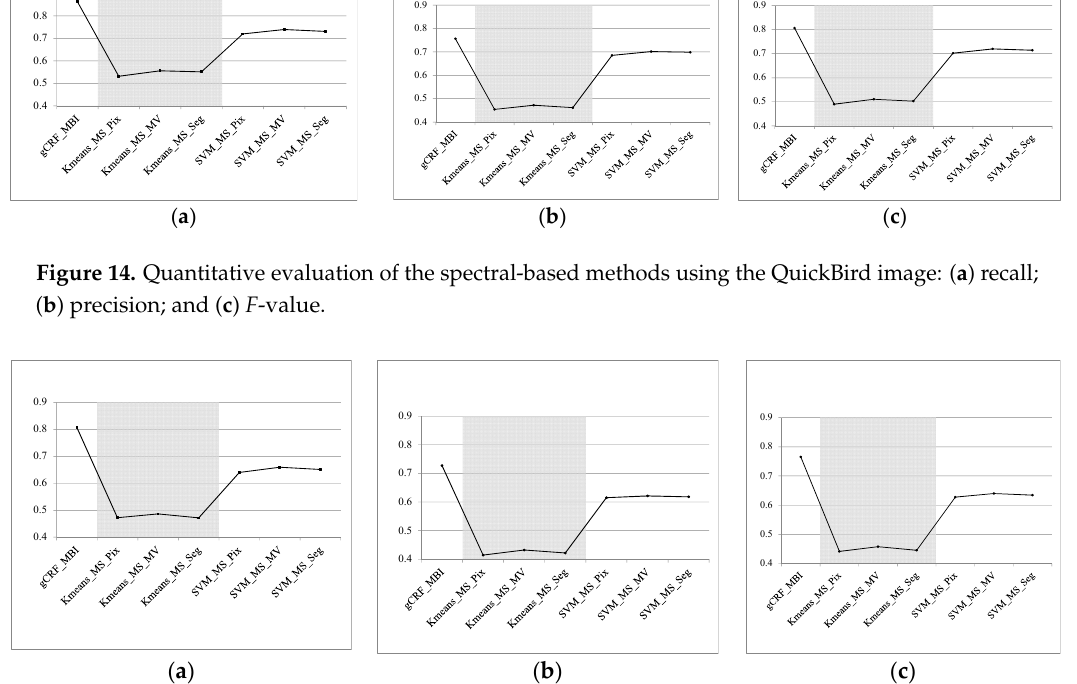
Figure 15. Quantitative evaluation of the spectral-based methods using the Pléiades image: ( a ) recall; ( b ) precision; and ( c ) F -value.